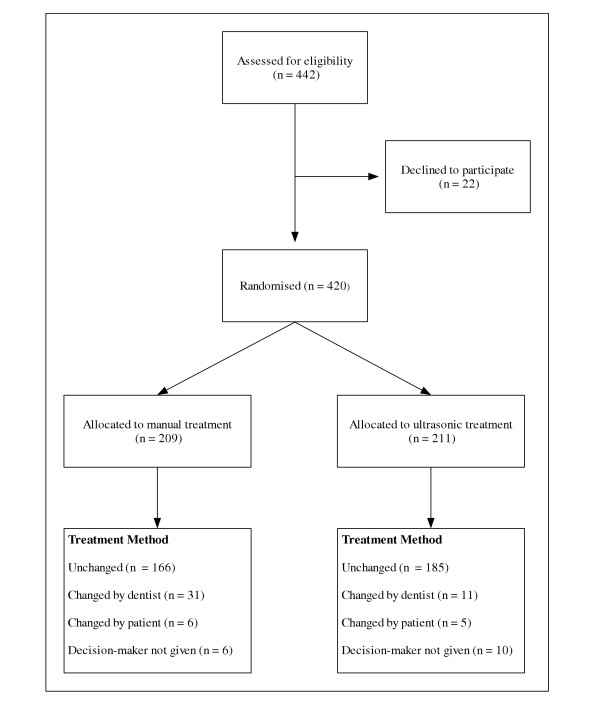
Flow of patients through the randomised controlled trial.